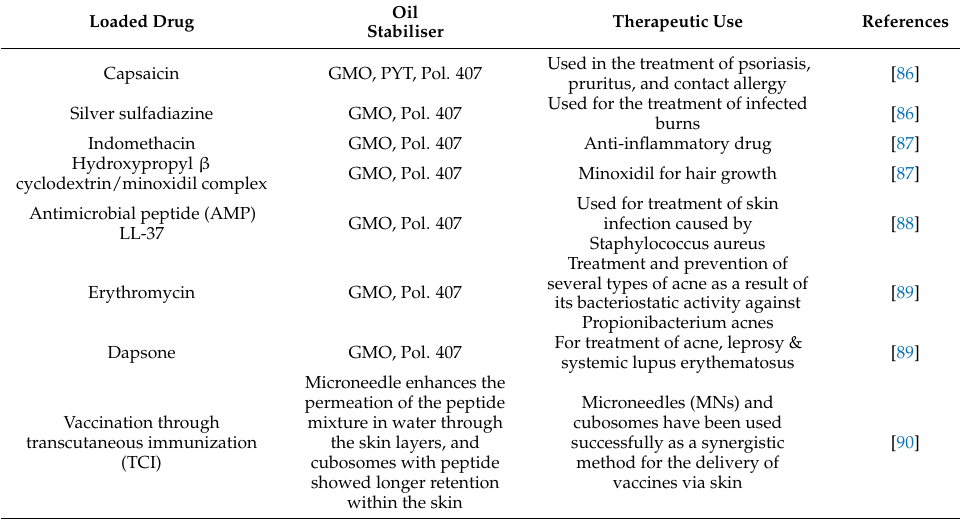
Table 9. Dermatological applications of